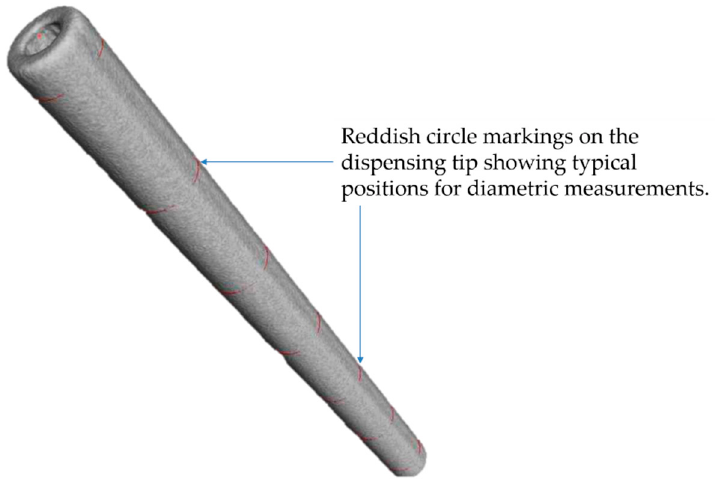
Figure 2. X-ray computed tomography (xCT) image showing a 3D rendering of the surface of capillary of a stainless-steel dispensing